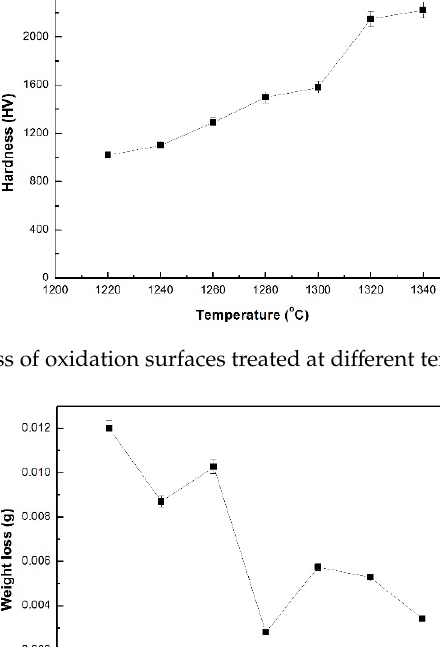
Figure 8. Hardness of oxidation surfaces treated at different temperatures for 3 h.